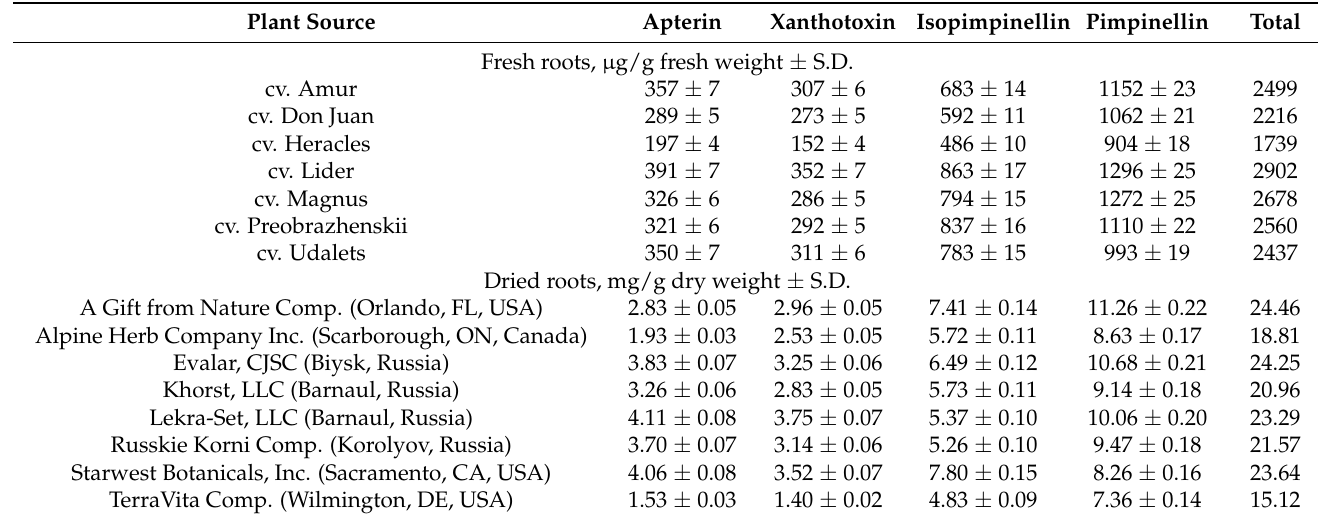
Table 4. Content of four coumarins in fresh and dried lovage